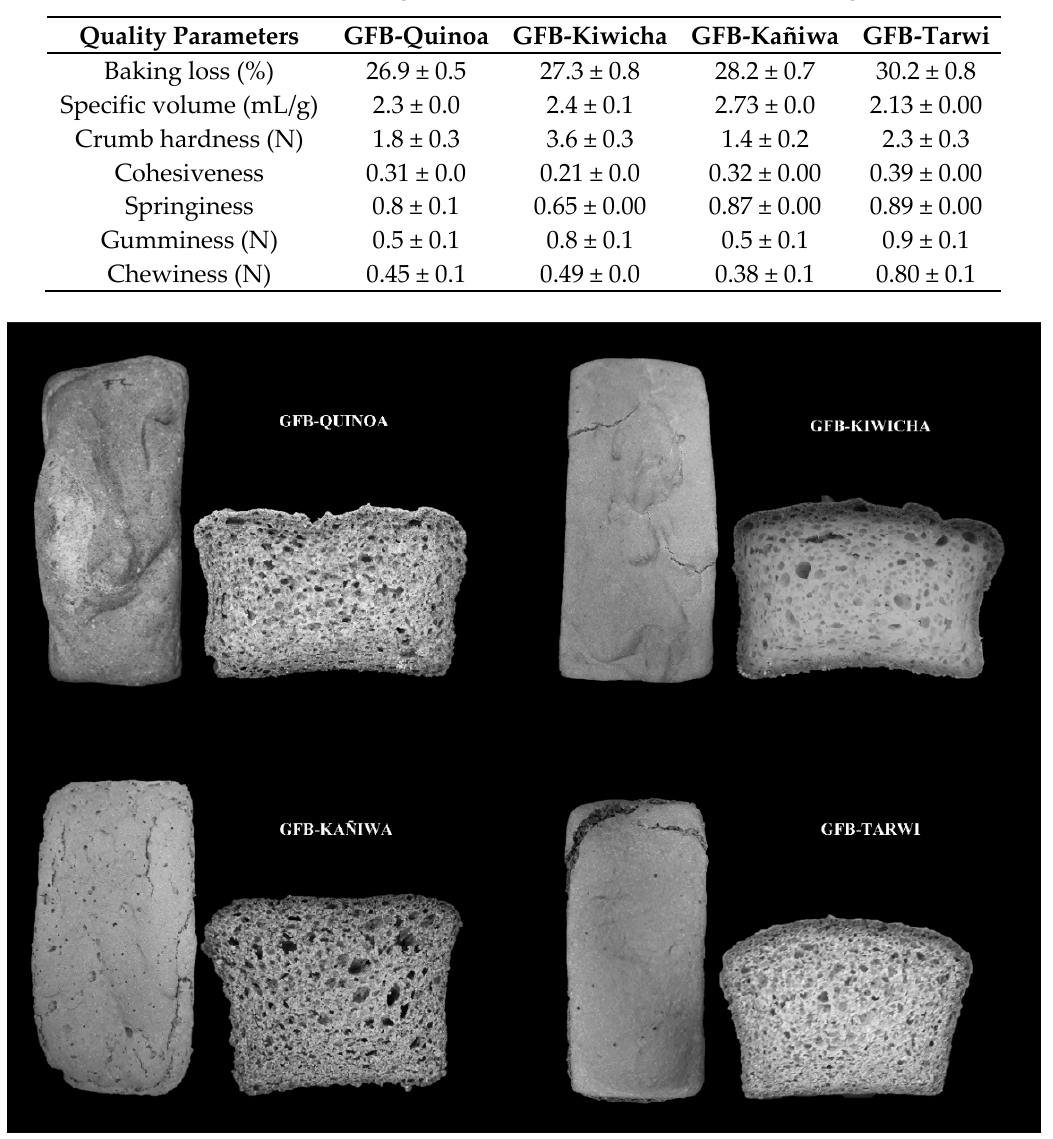
Figure 1. Representative images of gluten-free breads (GFB) with quinoa, kiwicha, kañiwa and